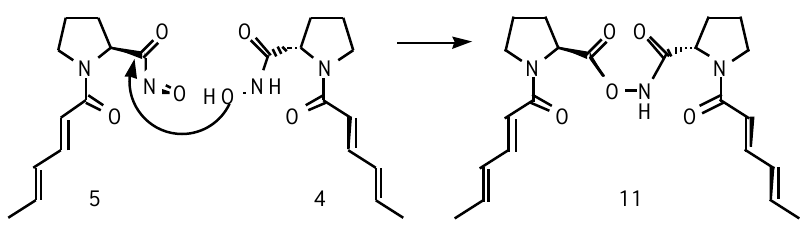
Scheme 1. Synthesis of the intermediate 6 .